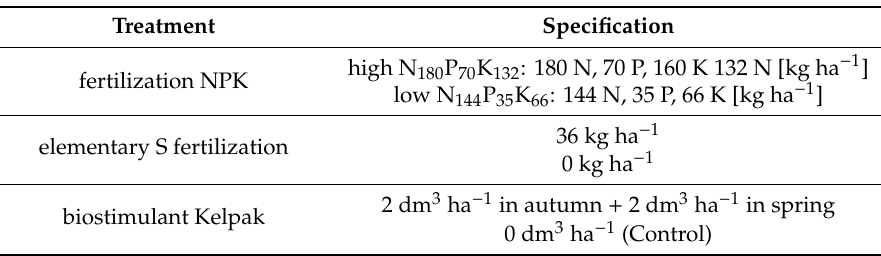
Table 1. Fertilization in